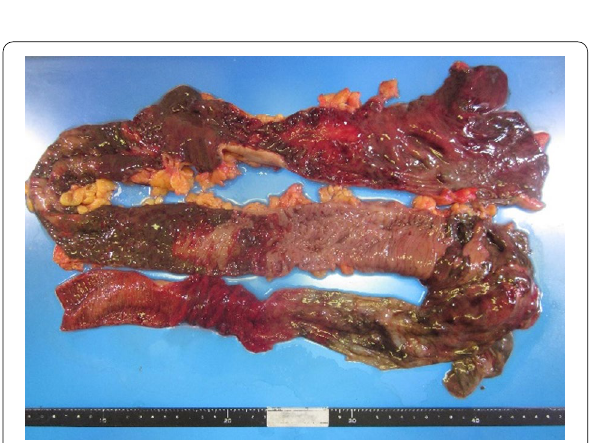
Fig. 3 Excised specimen findings. The excised specimen showed scattered necrosis in the ascending, transverse, and sigmoid colon